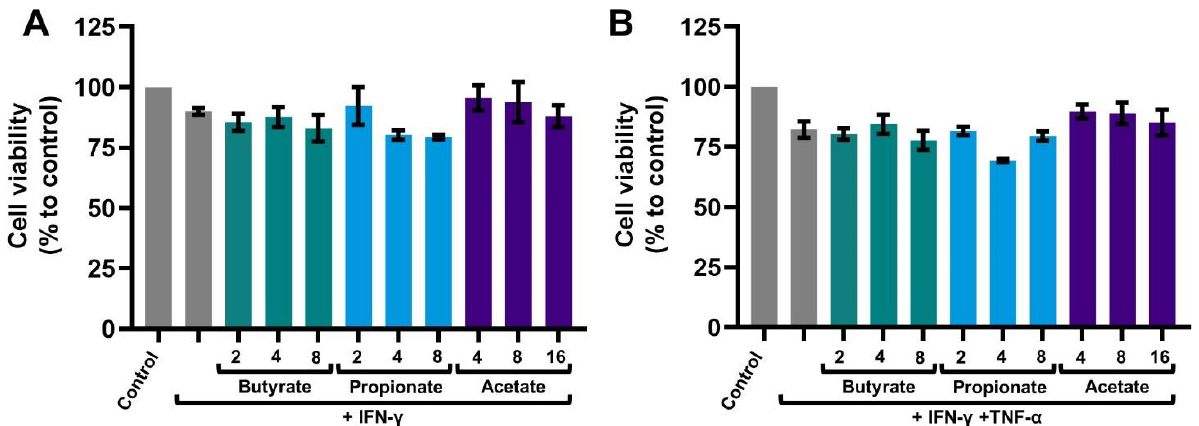
Figure A1. Viability of intestinal epithelial cells after 24 h, activated with IFN- γ ( A ) or IFN- γ +TNF- α ( B ) and treated with 2, 4, 8 and 16 mM butyrate, propionate or acetate. Data are represented as mean ± SEM ( n = 3).